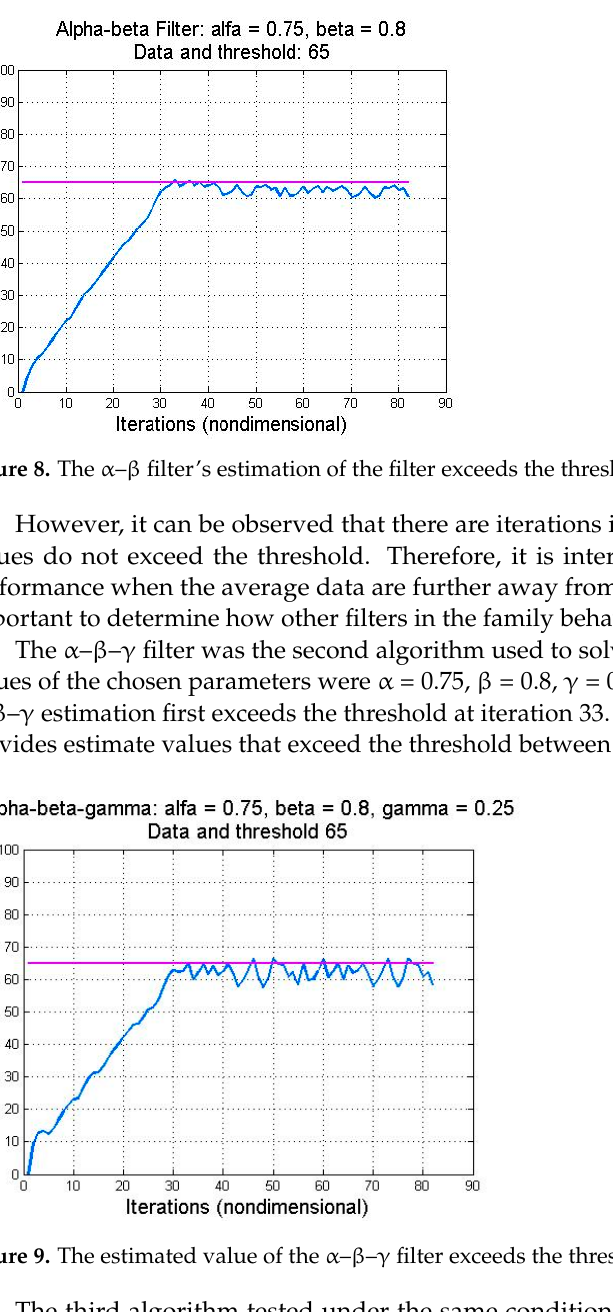
Figure 9. The estimated value of the α – β – γ filter exceeds the threshold at iteration 33.